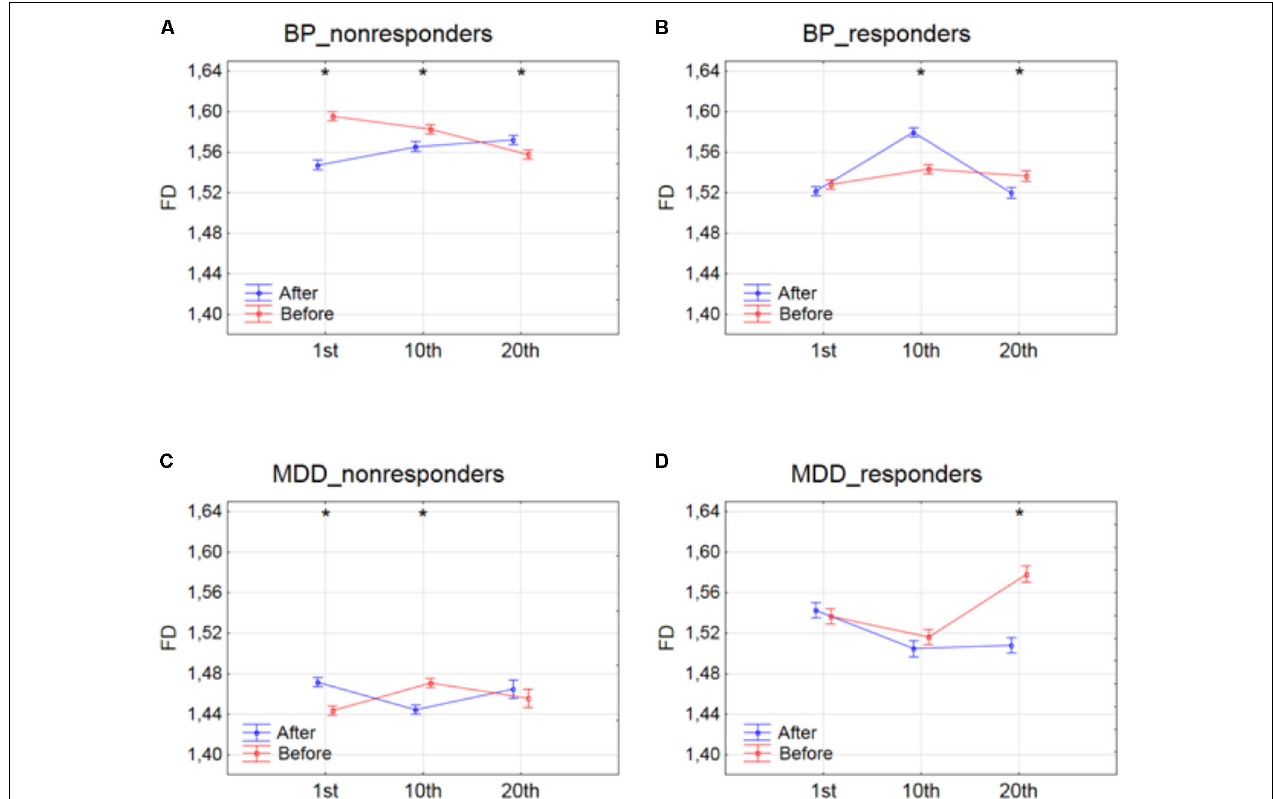
FIGURE 2 | Higuchi fractal dimension for BP_non-responders (A) , BP_responders (B) , MDD_non-responders (C) and MDD_responders (D) before and after stimulation in successive sessions (1st, 10th, and 20th session). The interaction between factors CONDITION and SESSION (all frequency bands were included). Significant differences between conditions for the individual sessions, evaluated by post hoc Tukey HSD test, were marked with